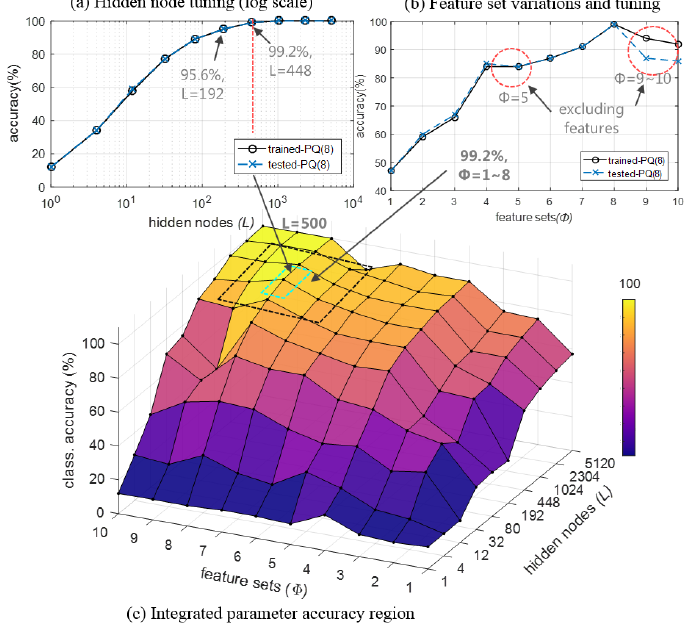
Figure 6. PQ classification accuracies through parameter changes.